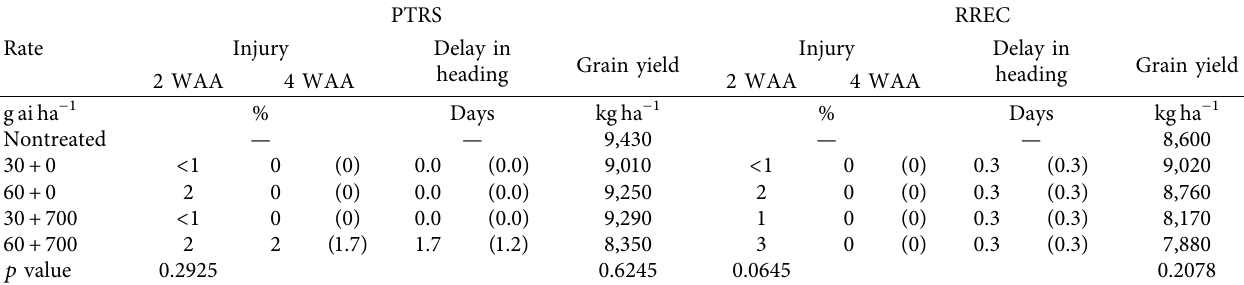
Table 8: Injury 2 and 4 weeks after application (WAA), heading delay, and grain yield response of CL111 to different rates of florpyrauxifen- benzyl and malathion applied preflood a,b .